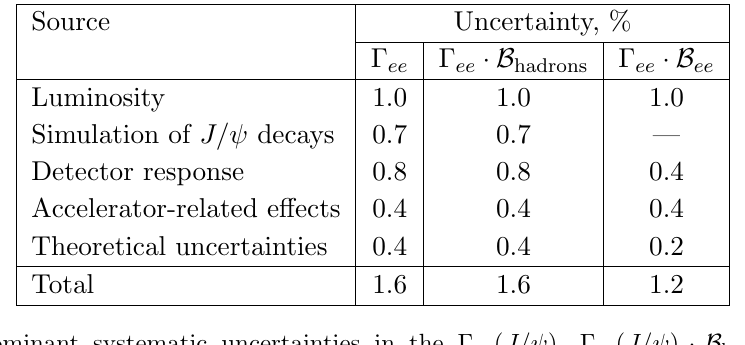
Dominant systematic uncertainties in the (cid:0) ee ( J= ), (cid:0) ee ( J= ) (cid:1) B hadrons ( J= ) and (cid:0) ee ( J= ) (cid:1) B ee ( J= ) values. Taking into account B ee ( J= ) = (5 : 971 (cid:6) 0 : 032)% from [6] we determined the